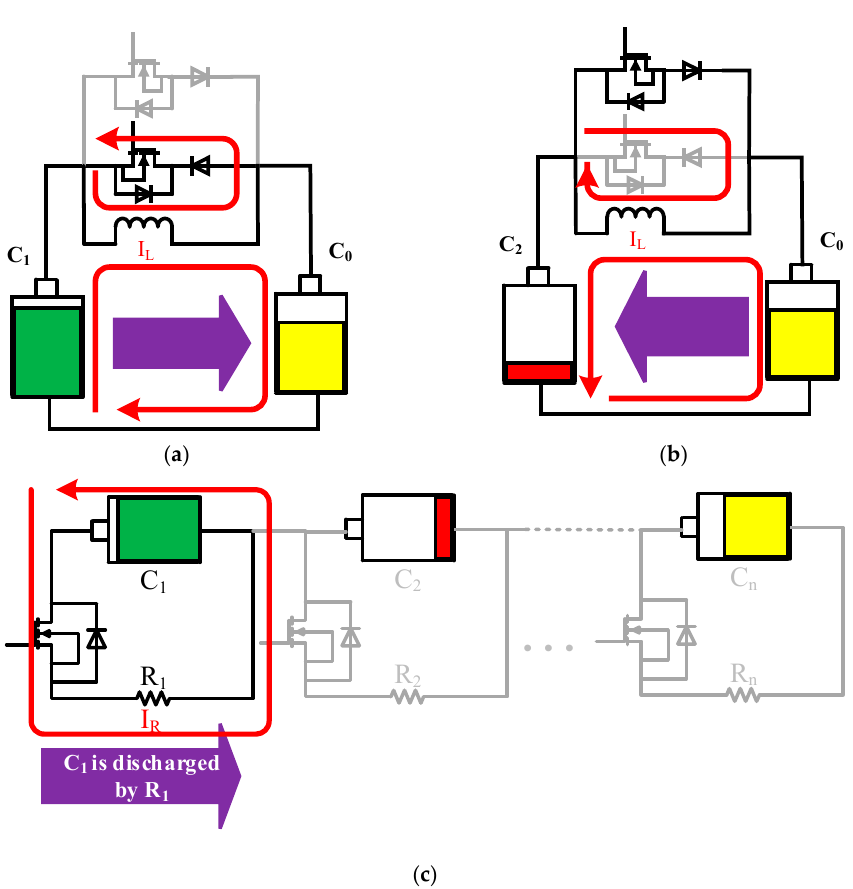
Figure 2. Principle of composite equalization. ( a ) First active equalization mode; ( b ) second active equalization mode; and ( c ) passive equalization mode.